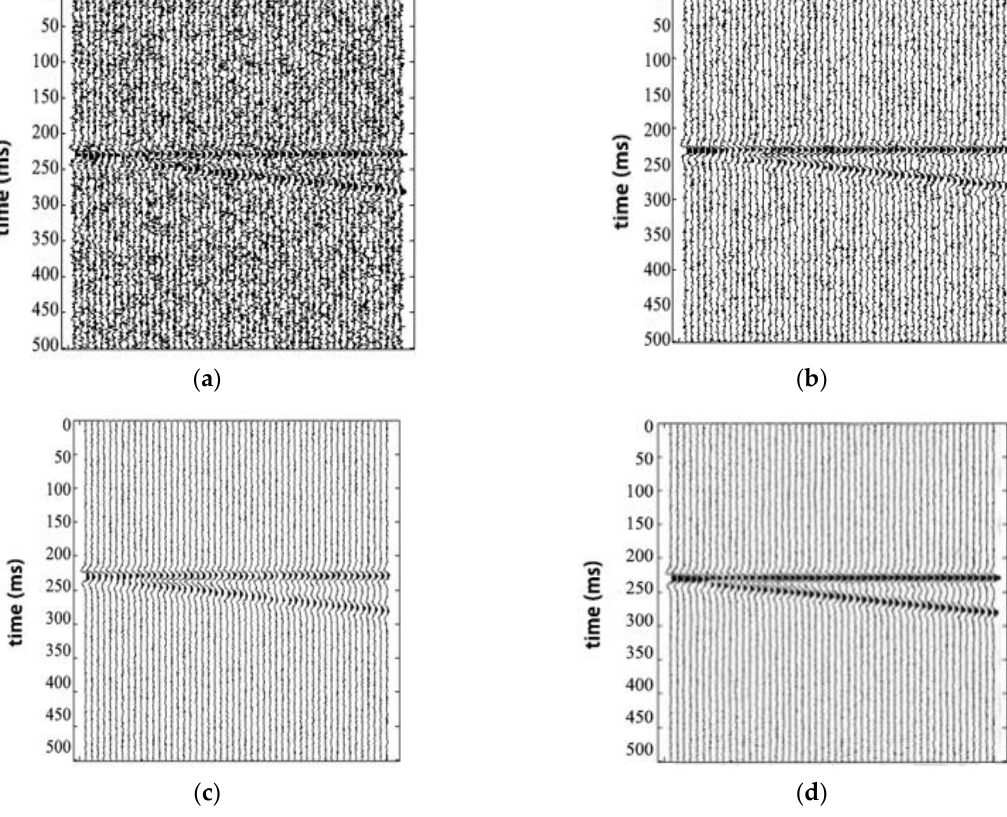
Figure 10. The chart of Wedge model between the original and processed: ( a ) The wedge model under strong noise background; ( b ) processed wedge model using the wavelet transform; ( c ) processed wedge model using the curvelet transform; ( d ) processed wedge model using EMDNN method.